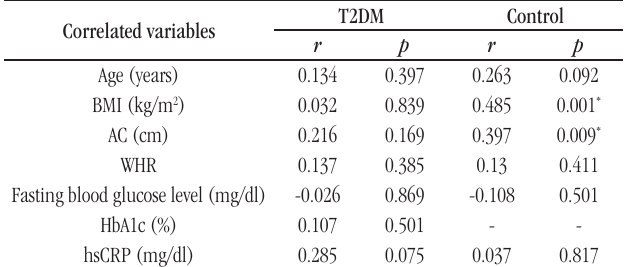
TABLE 2 – Correlations between Gal3 levels and clinical or laboratory variables for the T2DM with kidney disease group and the control group Correlated